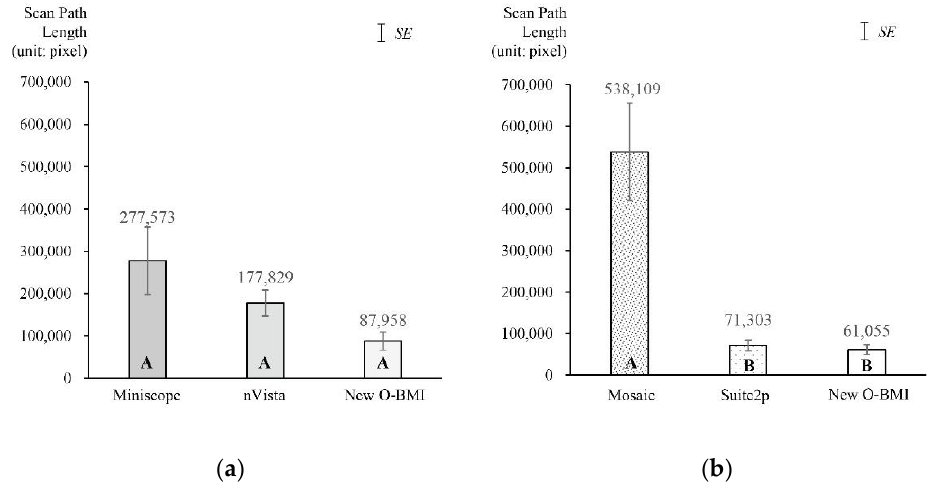
Figure 10. Comparison of O-BMI user interface designs in terms of scan path length. ( a ) video acquisition task; ( b ) signal extraction task.